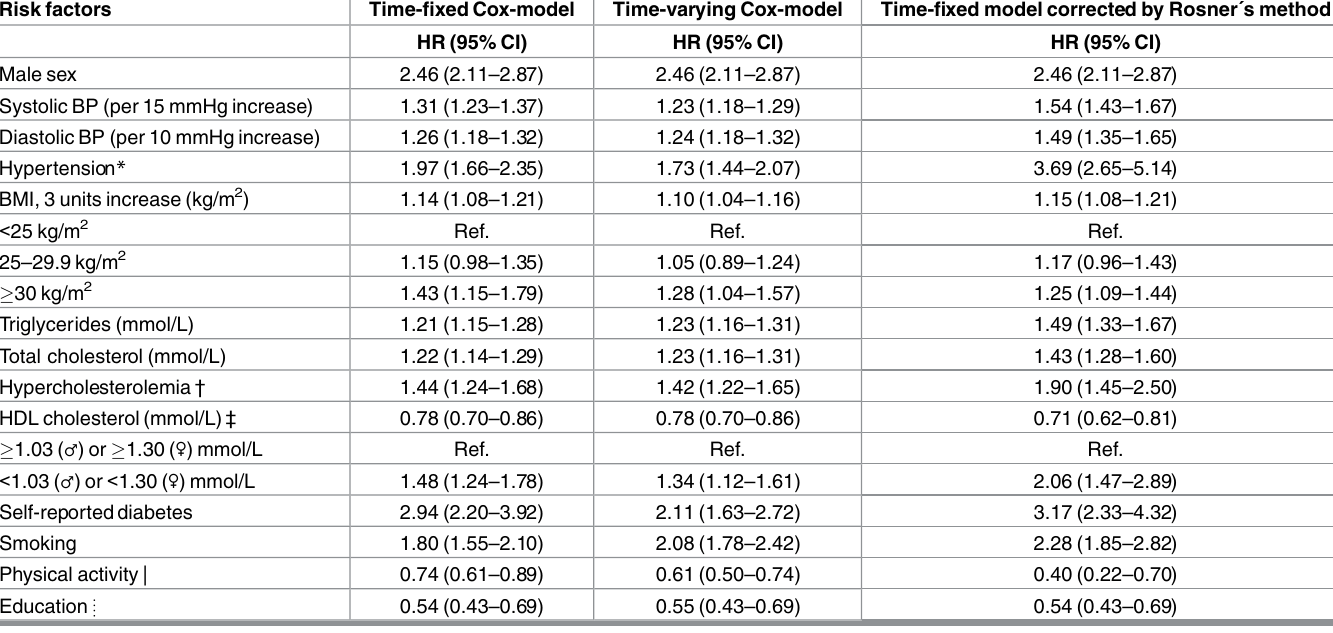
Table 2. Age (as time scale)-and sex-adjusted hazard ratios(HR)with95% confidence intervals(CI)for the risk of myocardial infarction(MI)by tra- ditionalatherosclerotic risk factors usingthreedifferentapproaches; time-fixedmodel,time-varyingmodeland correctionfor regression dilution throughRosners´s method. The Troms ø Study